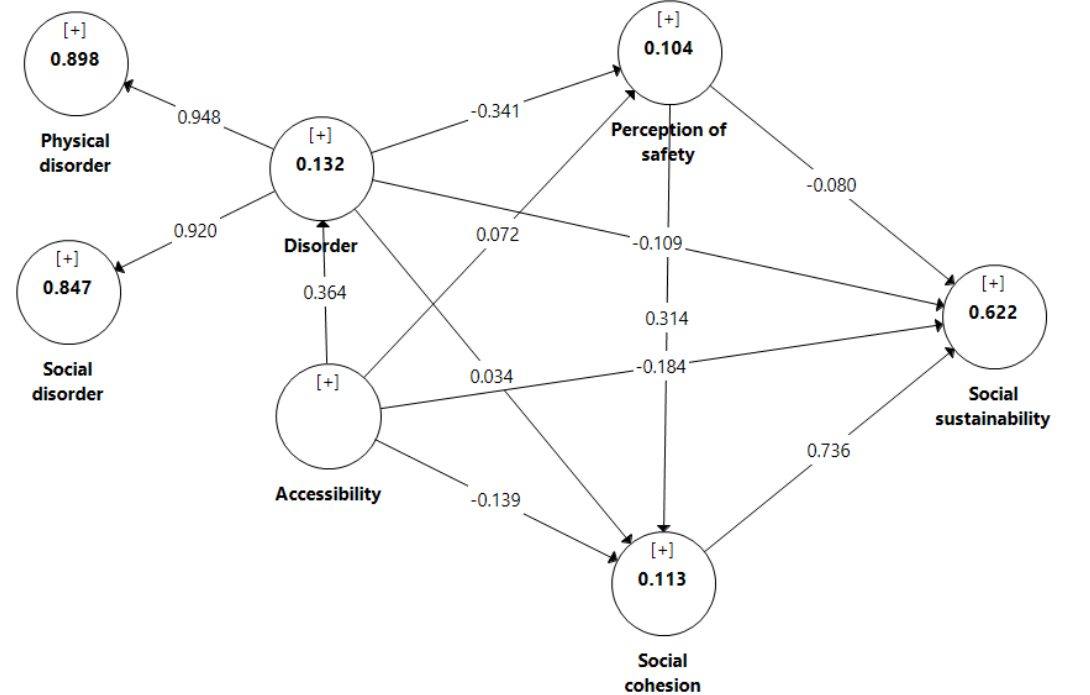
Figure 1. Parameter estimates of the PLS analysis.